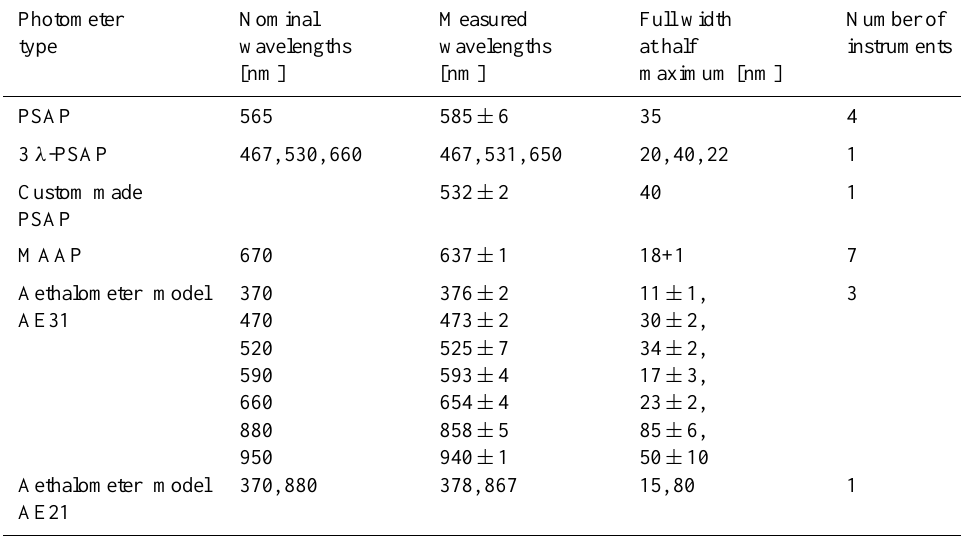
Table 6. Nominal and measured wavelengths of optical absorption